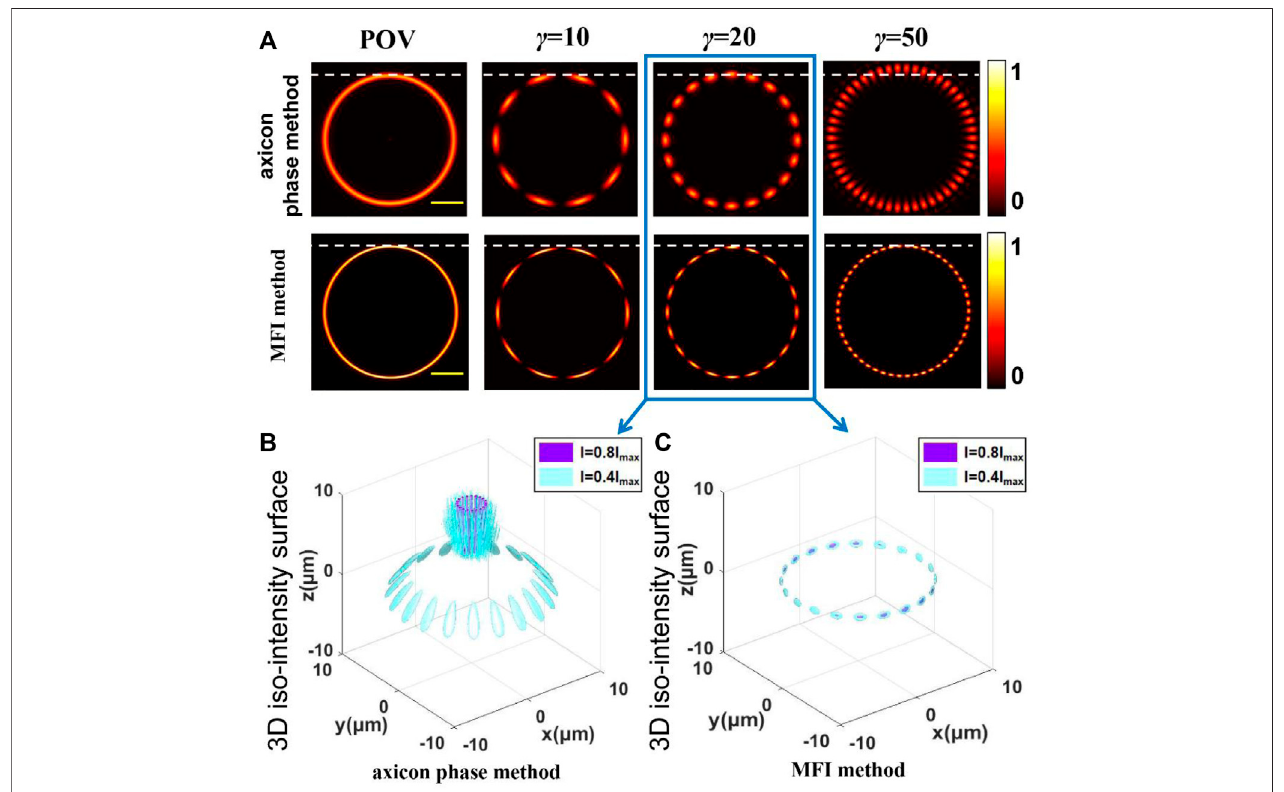
FIGURE 3 | (A) Simulated intensity distribution of POV and spot array fi eld in the focal plane produced by the axicon phase method and MFI method. (B,C) Simulation result of the normalized 3D intensity distribution of 20 spots produced by different methods. Scale bar: 4 μ m.